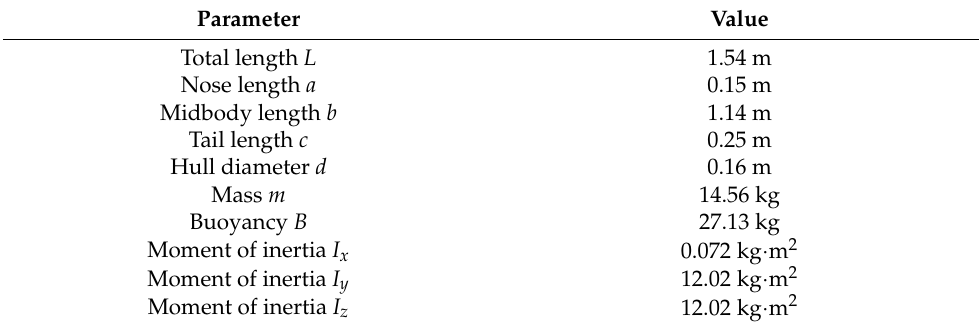
Table 2. Parameters of the controlled torpedo-like underwater vehicle.